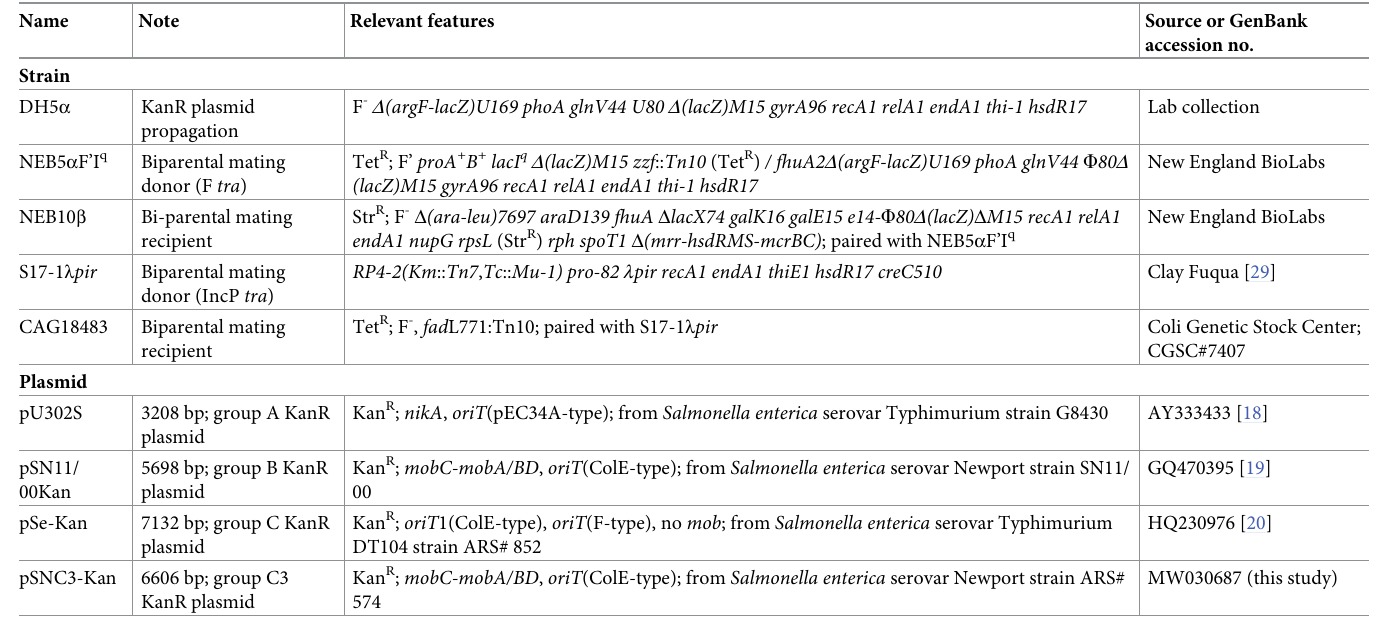
Table 1. Bacterial strains and plasmids used in this study.